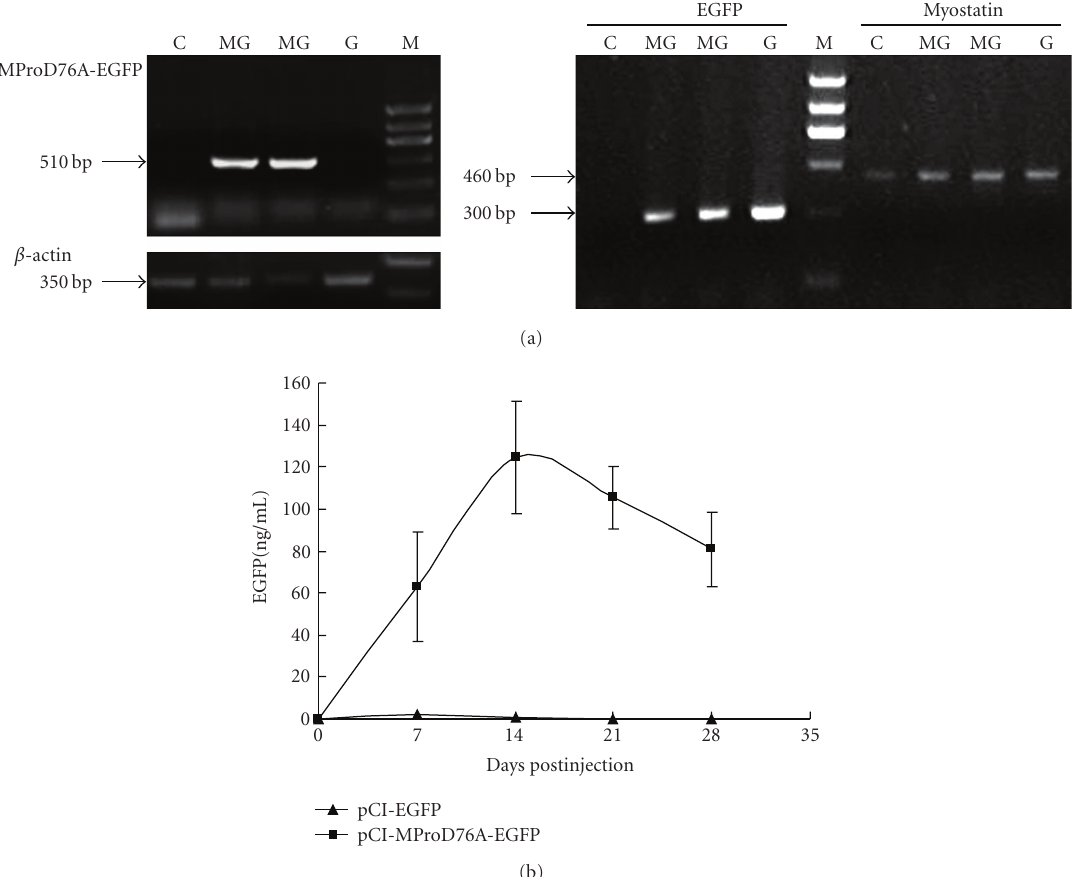
Figure 3: In vivo expression of pCI-MProD76A-EGFP in injected mice. (a) Expression of pCI-MProD76A-EGFP assayed by RT-PCR after intramuscular injection of pCI-MProD76A-EGFP into the quadriceps muscle of mice. Left panels: RT-PCR bands (510bp) for MProD76A- EGFP; RT-PCR bands (350bp) for β -actin, which served as an internal control. Right panels: RT-PCR bands for EGFP (300 bp) and endogeous myostatin (460 bp). M, DNA markers; C, control muscle; MG, pCI-MProD76A-EGFP-injected muscle; G, pCI-EGFP-injected muscle. (b) The serum levels of the EGFP protein (ng/mL) in mice injected with pCI-MProD76A-EGFP or pCI-EGFP. The results are presented as means ± SEM, n =